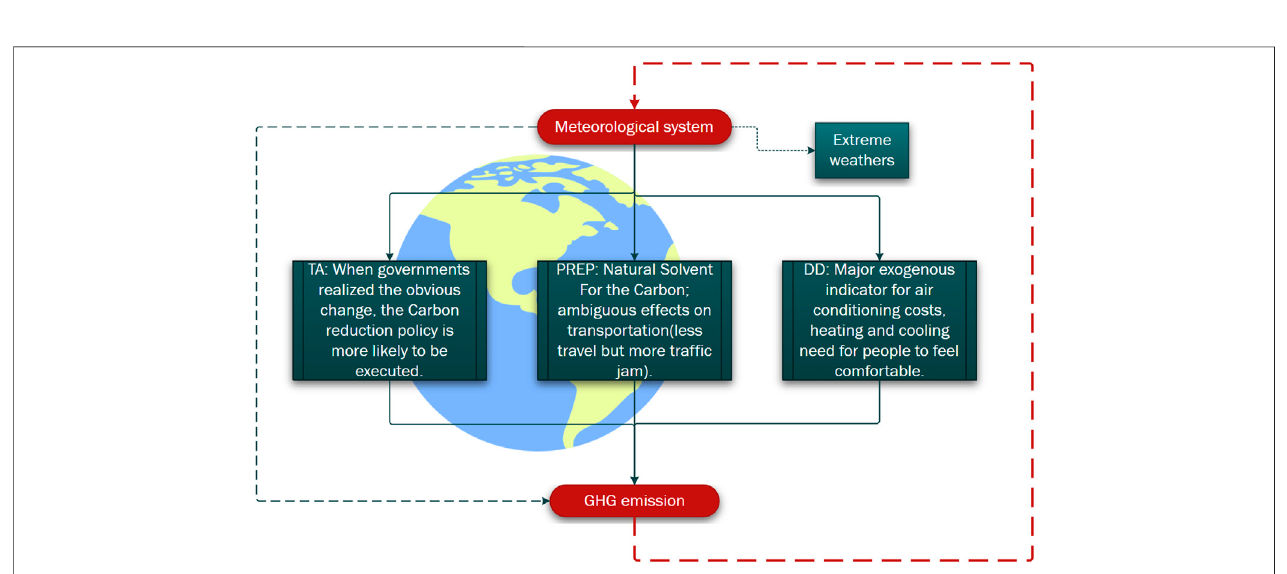
FIGURE 5 | The interactive mechanisms between carbon emission and the stability ofthe meteorologicalsystem, in accordance with the box diagram of the basic structure of the mathematical model of global climate in Syukuro and Stouffer (1980).